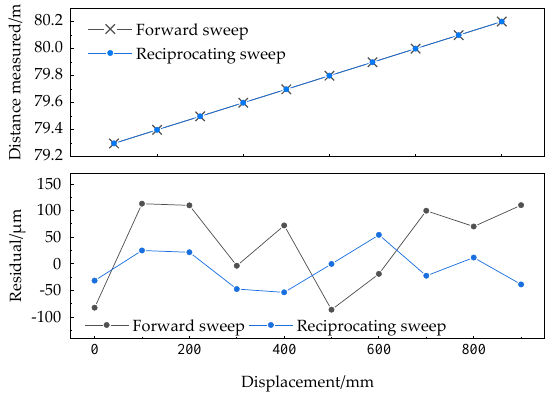
8 of 9 Figure 7. Residuals of the measured distance versus displacement from a commercial heterodyne interferometer. 4. Conclusions We systematically discussed the principle of the FSPM based ranging method and the impact of